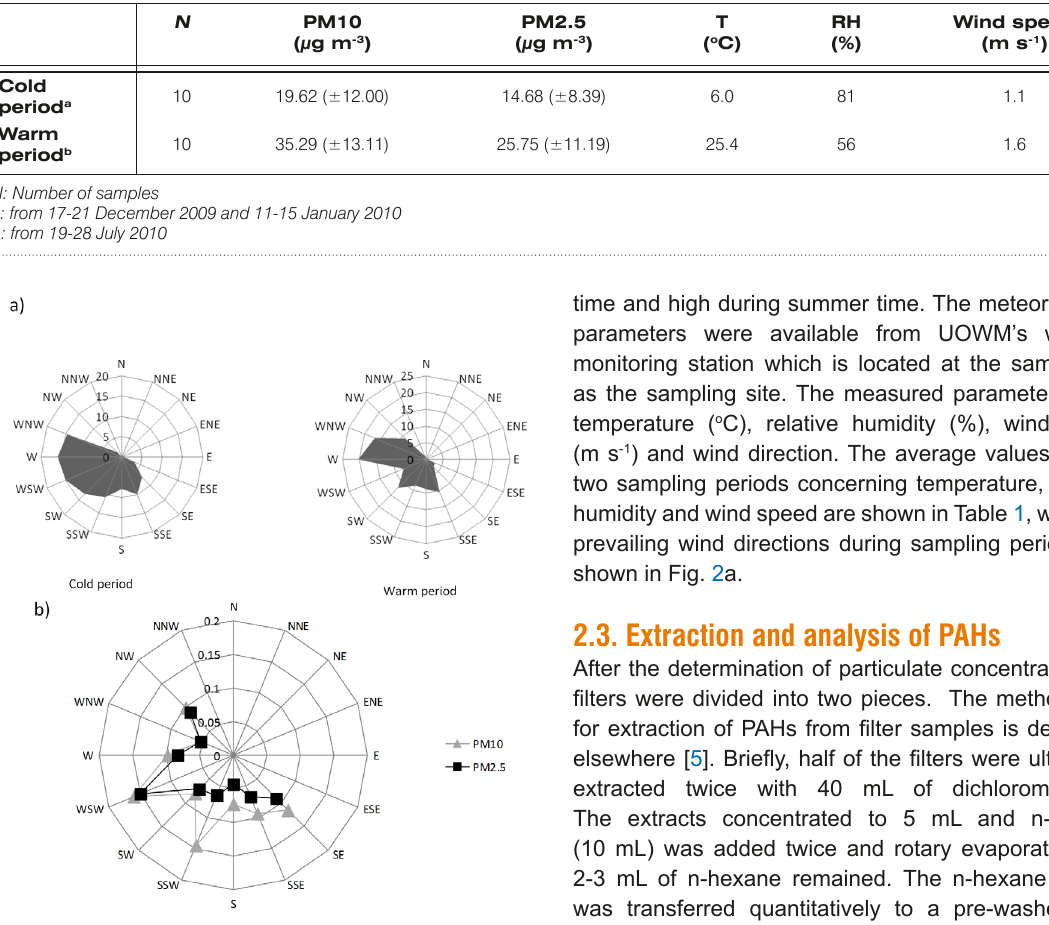
Table 1. Mean concentration and standard deviation of PM10 and PM2.5 with mean meteorological parameters for the city of